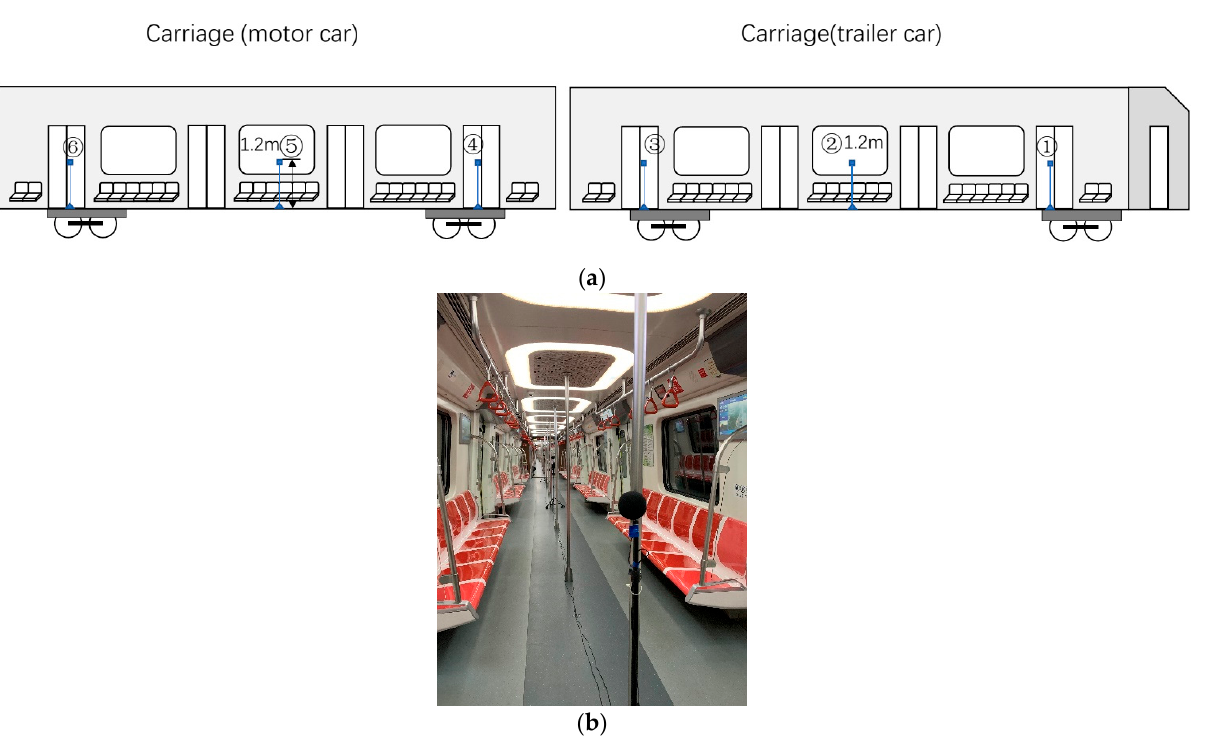
Int. J. Environ. Res. Public Health 2022 , 19 , x FOR PEER REVIEW Figure 8. Microphones in the error analysis of sensor location. ( a ) Microphone arrangement; ( b ) Test picture.